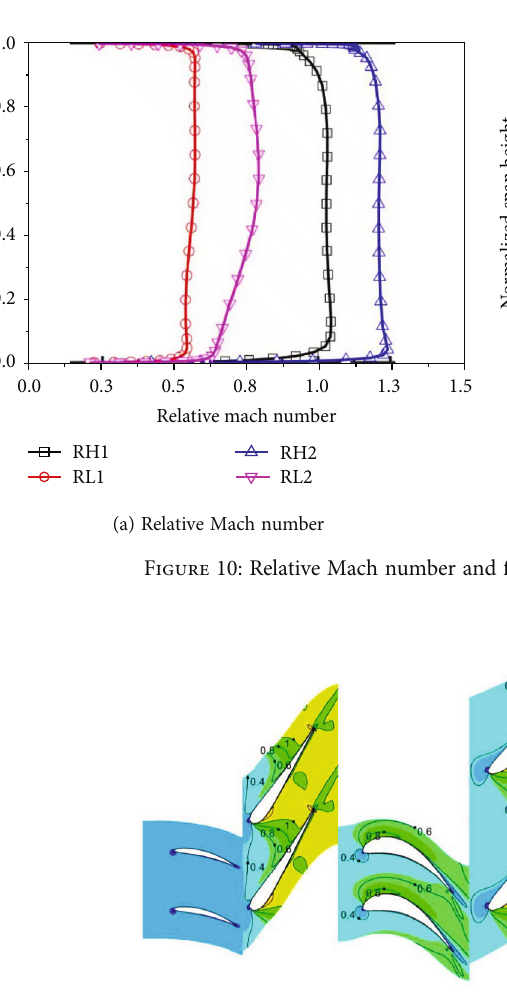
Figure 9: Wall Y + distribution